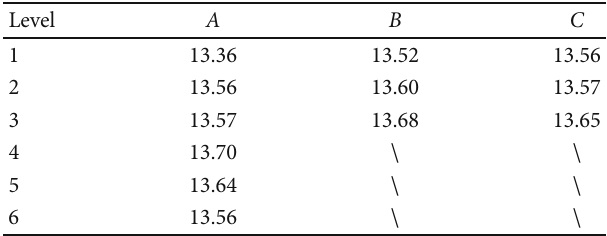
Table 8: The average value of T